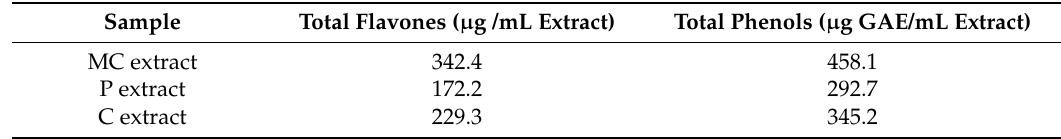
Table 2. Spectrophotometric quantification of flavonoids and total phenols in investigated extracts.